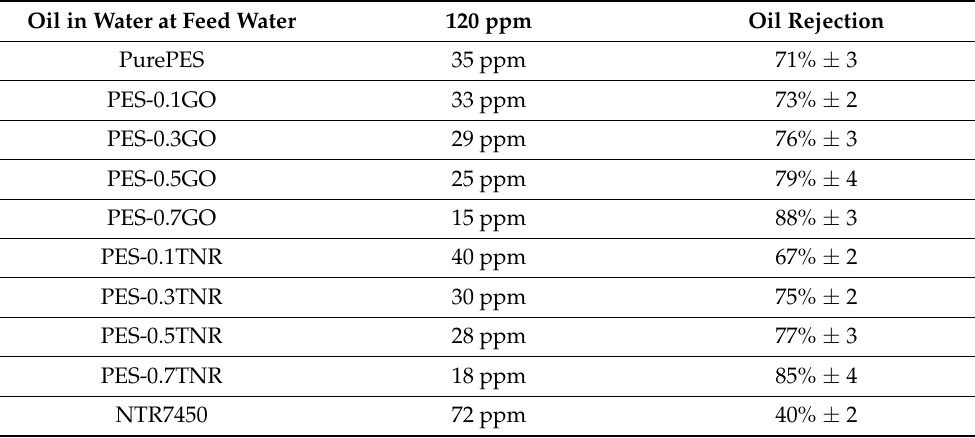
Table 5. Oil in water removal efficiency using synthesized membranes. Oil in Water at Feed Water 120 ppm Oil Rejection PurePES 35 ppm 71% ± 3 PES-0.1GO 33